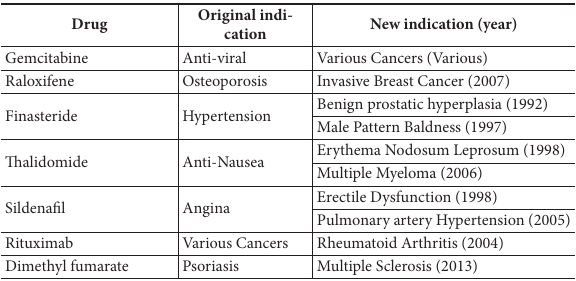
Table 4. Top mini-blockbuster and blockbuster repurposed